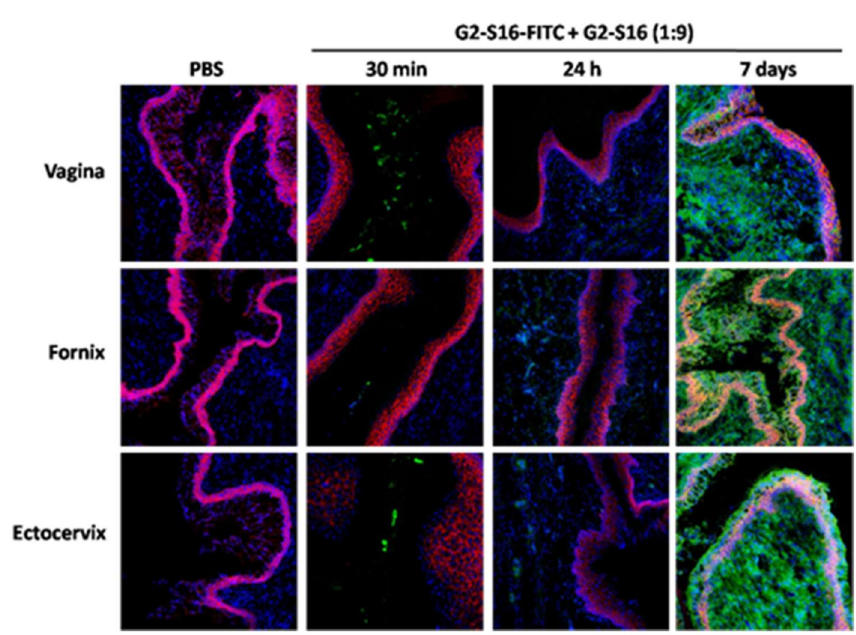
Figure 2. Accumulation of G2-S16-FITC dendrimer in the vagina, fornix and ectocervix of BALB/c mice. PBS control or G2-S16-FITC and G2-S16 dendrimers (at 1:9 rate) were applied in the vagina mice, and tissue samples of vagina, fornix and ectocervix were observed at 30 min, 24 h and 7 daily applications. Samples were stained with CD192-Alexa Flour 647 and